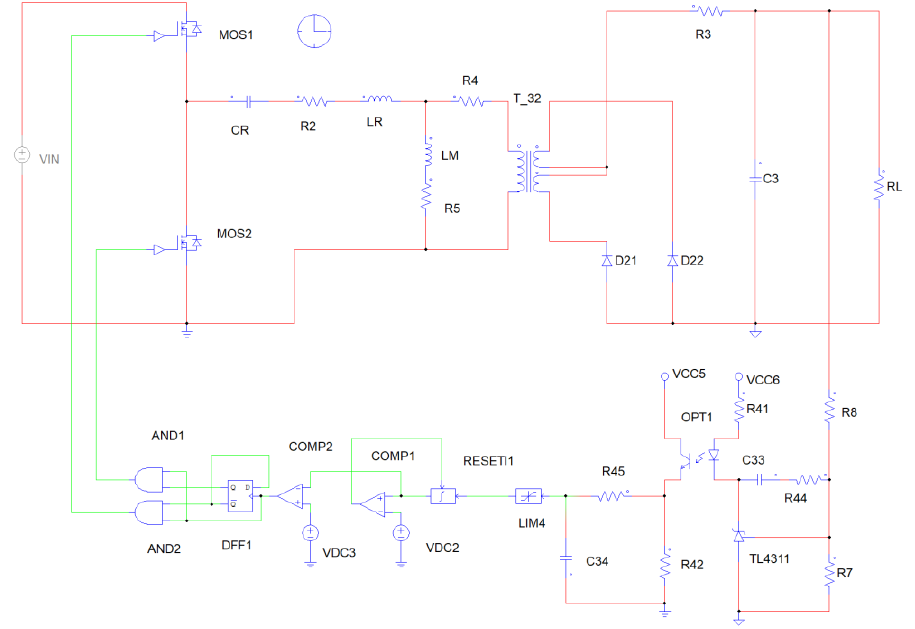
Figure 14. PSIM simulation schematic of a half-bridge LLC resonant converter.